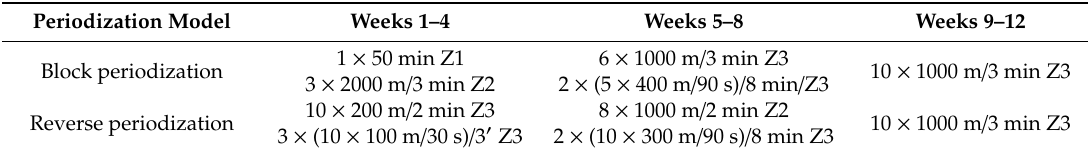
Table 1. Examples of typical training series in each phase of the 12-week training period for both block and reverse training periodizations.